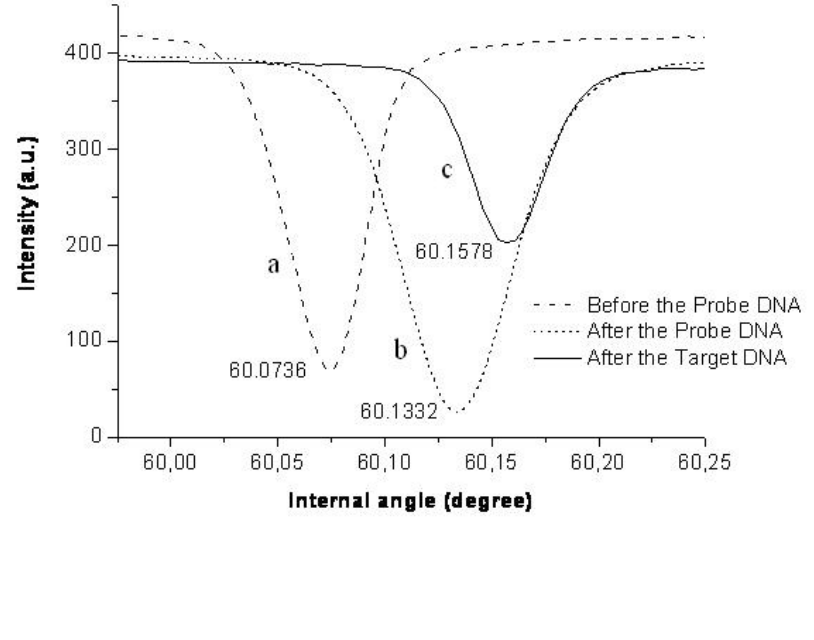
Figure 8. The resonant angles: (a) before probe DNA immobilization; (b) after probe DNA immobilization; (c) after target DNA hybridization